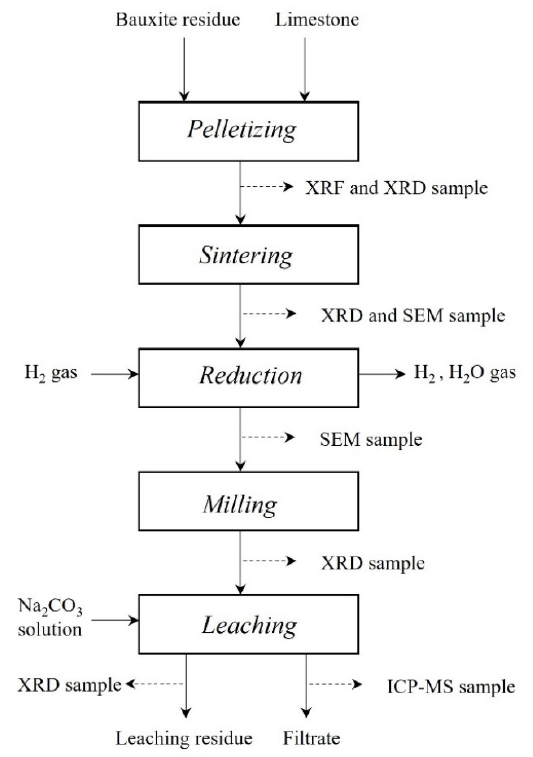
Figure 1. A schematic overview of the experimental procedure and applied characterization tech- niques.